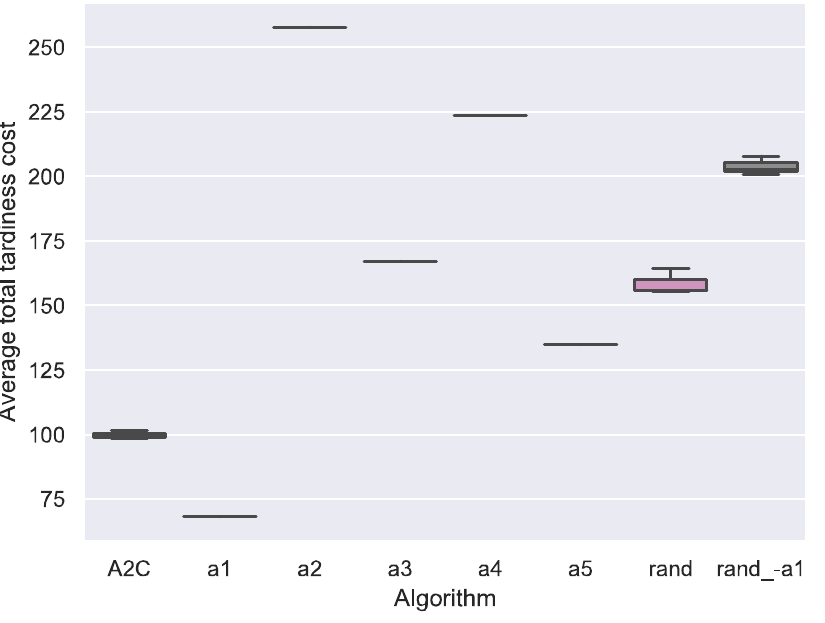
Figure 4. Comparison between A2C and SDR considering average total tardiness cost on all test instances.